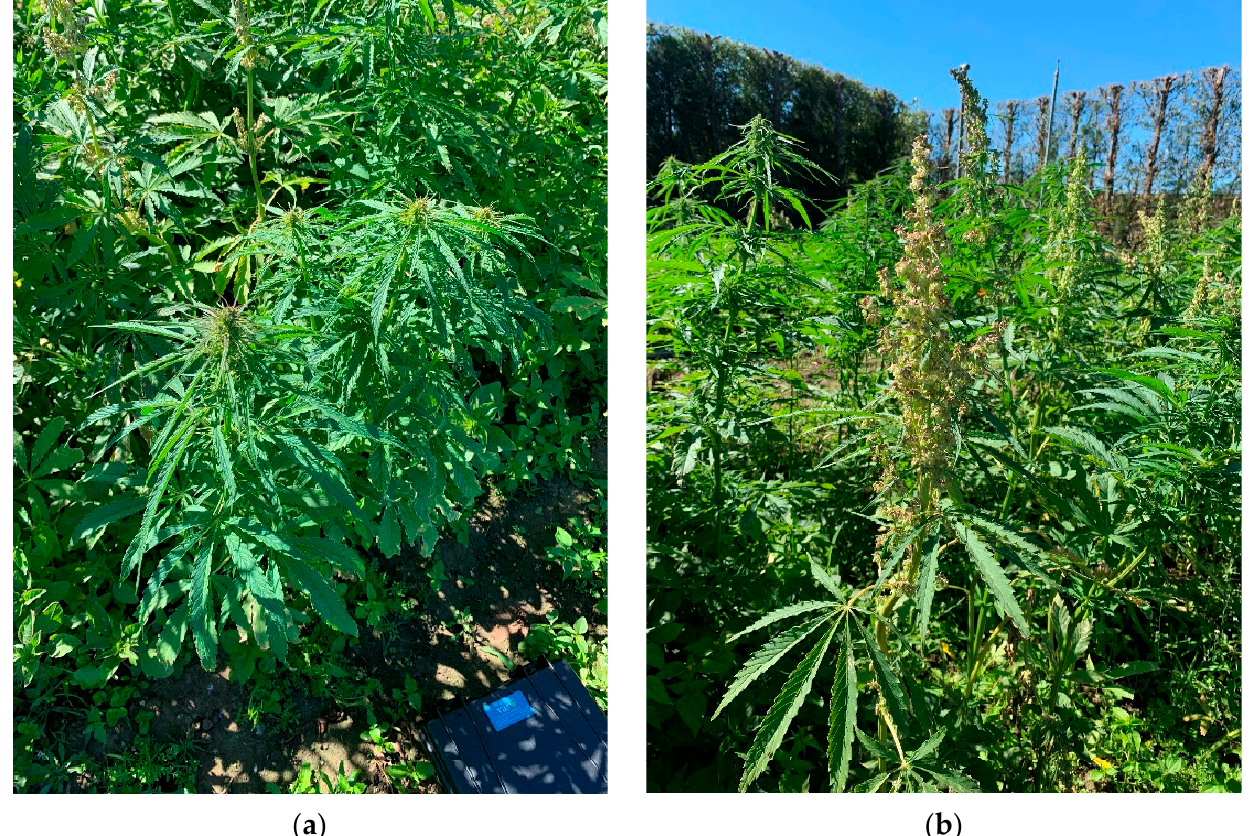
Figure 1. Eight-week-old hemp plants used for volatile collection: ( a ) Female hemp plants; ( b ) Male hemp plants.